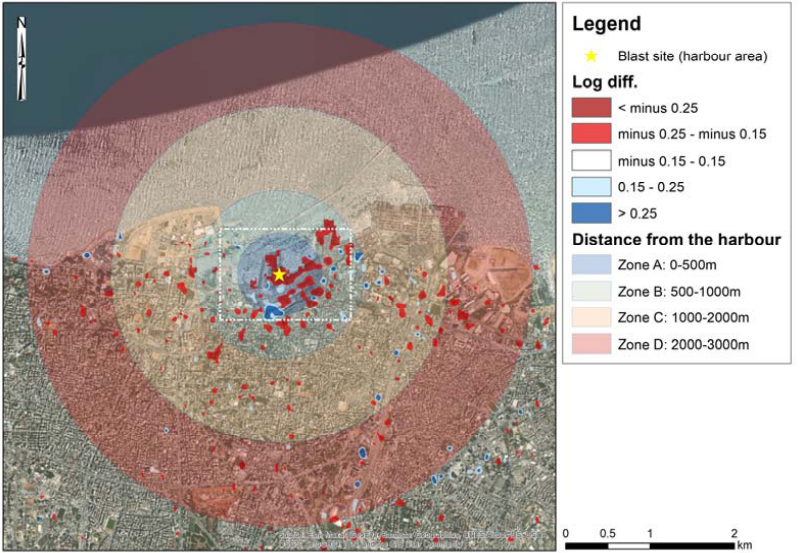
Figure A2. Change detection results using the log difference of the VV backscattering amplitude. Significant changes of the pair of images are presented with dark red and blue colors (> − 0.25 or >0.25 differences), while other minor changes in the range of − 0.25 to − 0.15 and 0.15 to 0.25 are also presented in light red and blue colors, respectively. The four zones under study (Zone A to Zone D) are also given. The location of the blast size is shown with the yellow star. The white dashed rectangle around the blast site is indicating the zoomed-in area presented in Figure